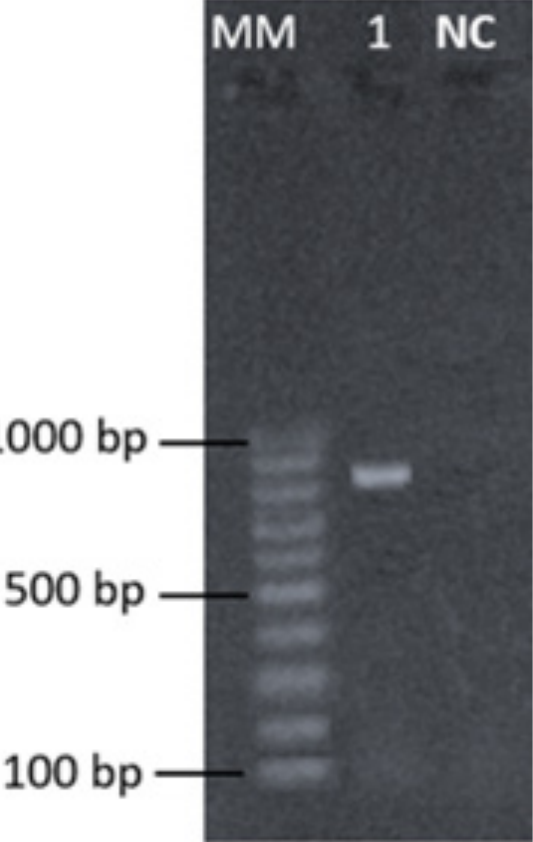
Figure 2. 1% agarose gel. MM= 100 bp molecular weight, 1: amplification of the 28S rDNA region (800 bp) using primers D2A and D3B, NC: Negative